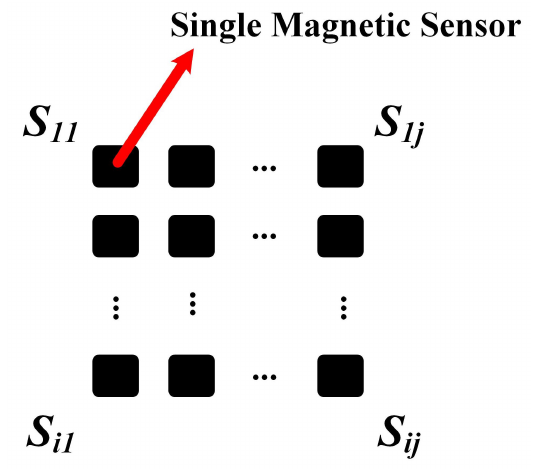
Figure 7. i × j Magnetic sensor